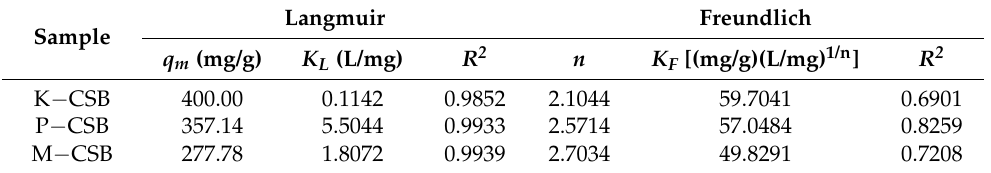
Figure 10. The adsorption isotherm models of TC adsorption on modified crab shell biochar (( a , c , e ) are Langmuir isotherm models of K − CSB, P − CSB, and M − CSB, respectively; and ( b , d , f) are Freundlich isotherm models of K − CSB, P − CSB, and M − CSB, respectively). Table 4. The adsorption isotherm model parameters of TC adsorption on modified carb shell